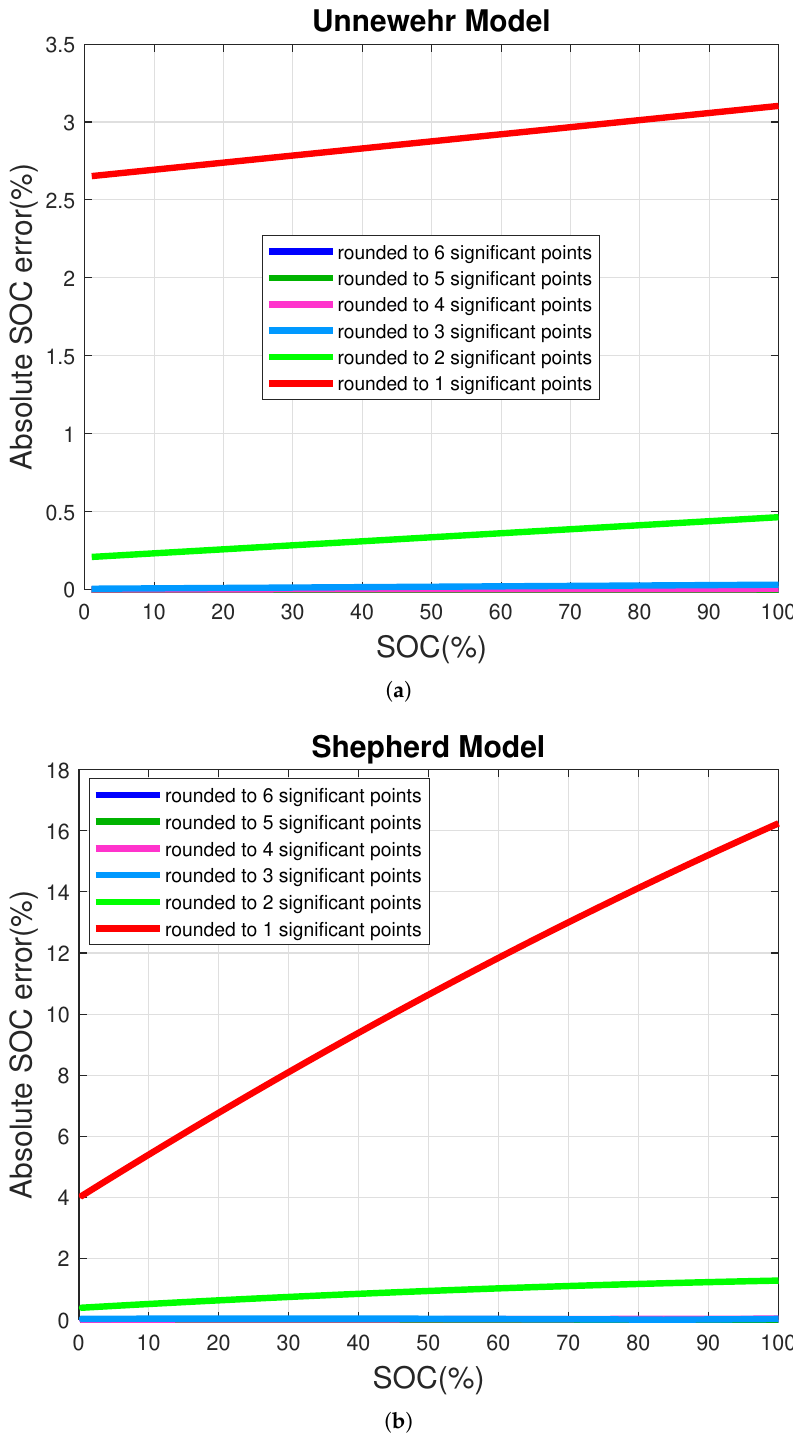
Figure 7. The effect of rounding in two different linear models; ( a ) the Unnewehr and ( b ) the Shepherd model is